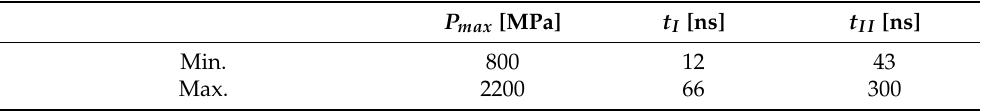
Table 2. Pressure pulse parameter ranges of maximum pressure P max , time of maximum pressure t I and pulse duration t II for training, validation and test data